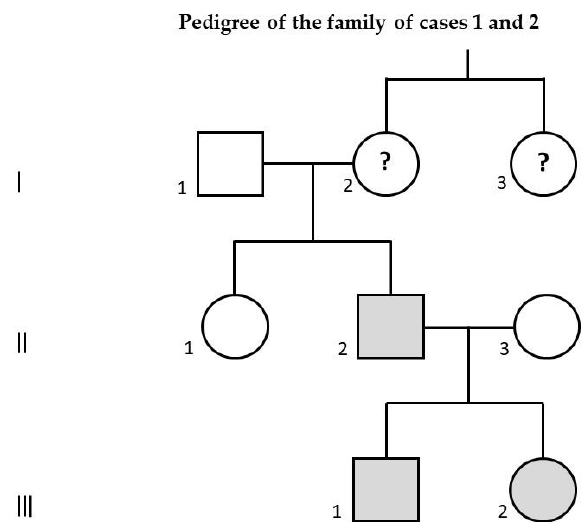
Figure 1. Family pedigree of case 1 (III-1), affected by autism spectrum disorder associated with intellectual disability, and of case 2 (III-2), affected by learning disability. Their father (II-2), presenting with the same 16p11.2 duplication, is affected by schizophrenia. His aunt (I-3) is also affected by schizophrenia: in her, the 16p11.2 duplication has not been documented and therefore it is only a hypothesis; if she were really a carrier of this duplication, evidently the paternal grandmother of cases 1 and 2 (I-2) would be a healthy carrier of 16p11.2 duplication. Gray color: confirmed carriers of 16p11.2 duplication; question mark: hypothetical carriers of 16p11.2 duplication.